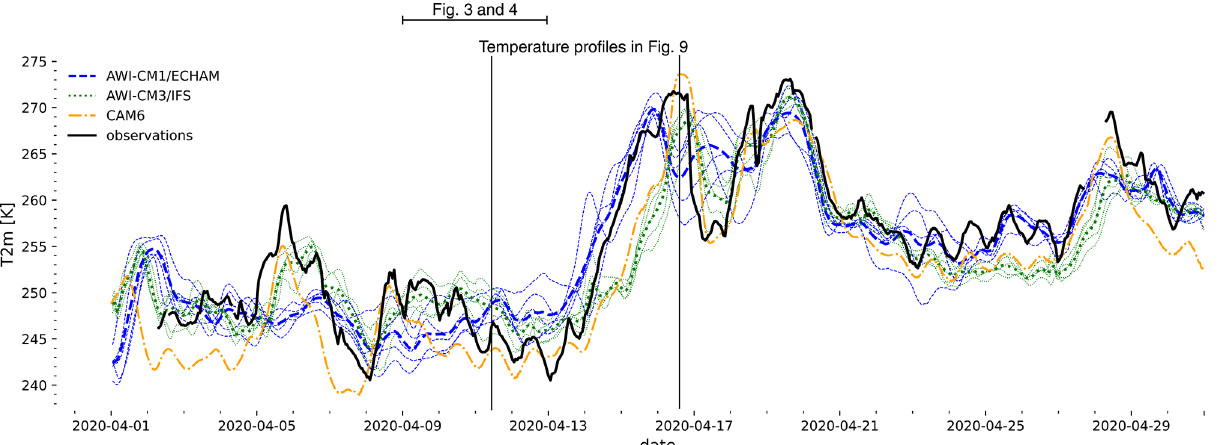
Figure 2. Observed and modelled hourly 2m temperatures during April 2020 at the MOSAiC site. Thin dashed and dotted lines show individual ensemble members, and the thicker lines show the ensemble mean for each AWI model. Throughout the paper, full black lines represent the observations, blue dashed lines AWI-CM1/ECHAM, green dotted lines AWI-CM3/IFS and orange dash-dotted lines CAM6. The period 9 to 12 April that we investigate in more detail and the timing of two soundings we analyse are indicated for reference.